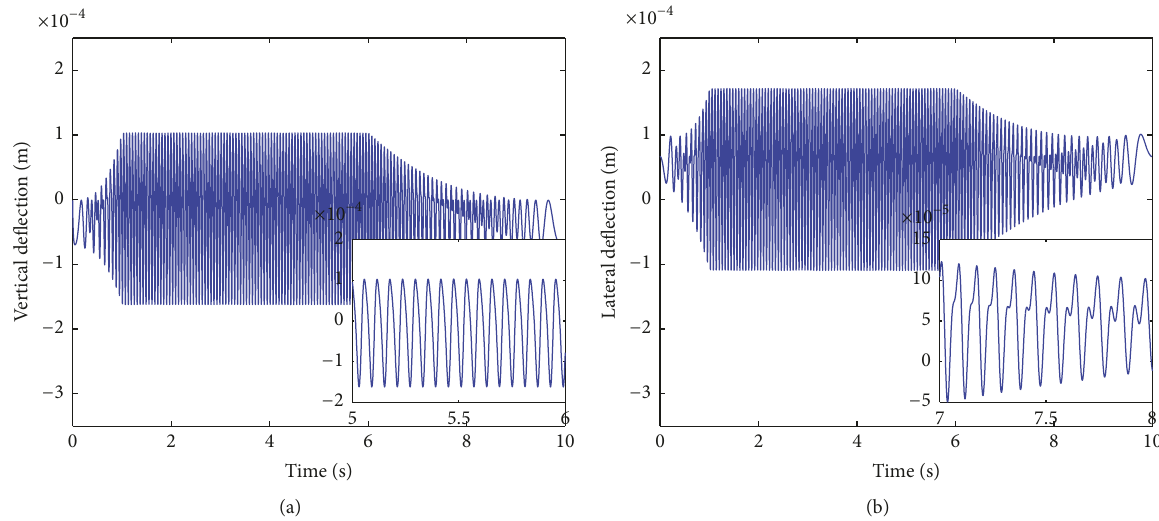
Figure 8: Bearing housing deflection with zoom in steady state in vertical (a) and with zoom in shutdown regime in lateral (b) directions for the total